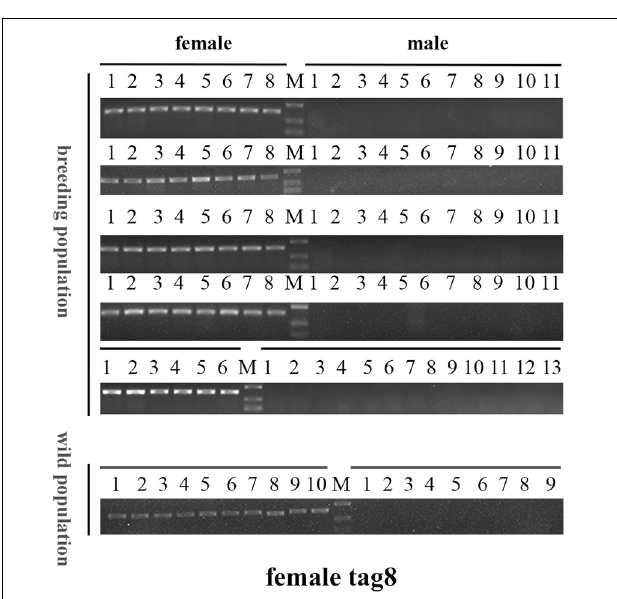
FIGURE 8 | Electrophoretogram of the amplified products using female-tag 8 for genotypic sex identification in M. nudus . Label M represents the DL2,000 DNA marker (500 and 250 bp DNA ladder are